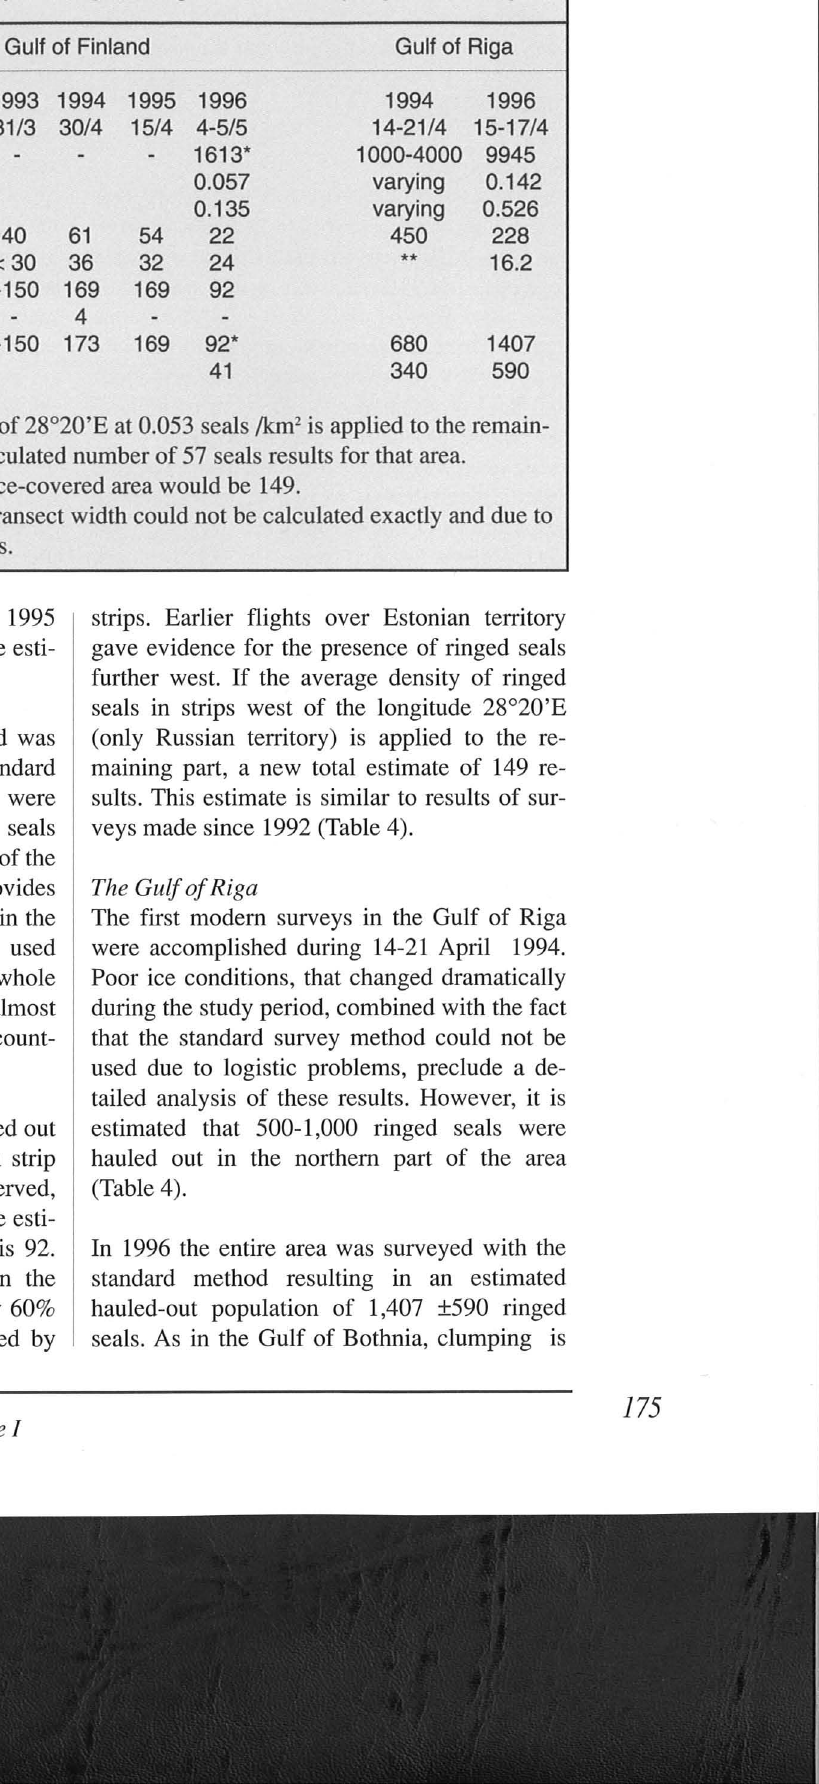
Table 4. Survey results of hauled-out ringed seals in the Gulf of Finland in 1992- 1996, and in the Gulf of Riga in 1994 and 1996. Sampling fractions for the surveys of 1992 and 1993 ·in the Gulf of Finland are not available, and thus the estimates are unreliable. In the Gulf of Finland a variant of the strip census method was used in 1994 and 1995 (see text), and the population assessments can be used as gross indications of population size. In 1996 the total ice covered area was 2,688 km2, but only 60% (1,613 km 2 ) could be covered by the range of strips due to military regulations (Fig.